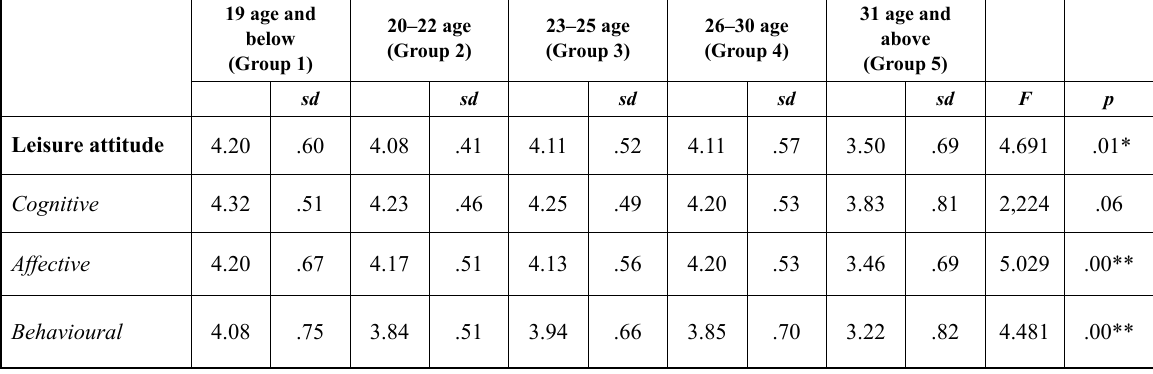
Table 9. Leisure attitude levels of ındividuals living in western cities by the variable of